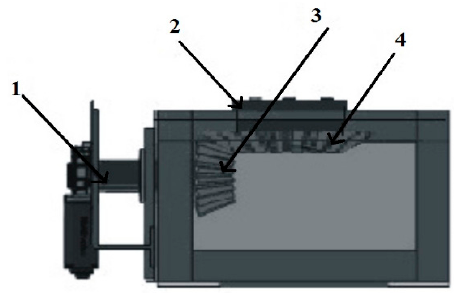
Figure 5. Proposed azimuthal solar tracker mechanism.